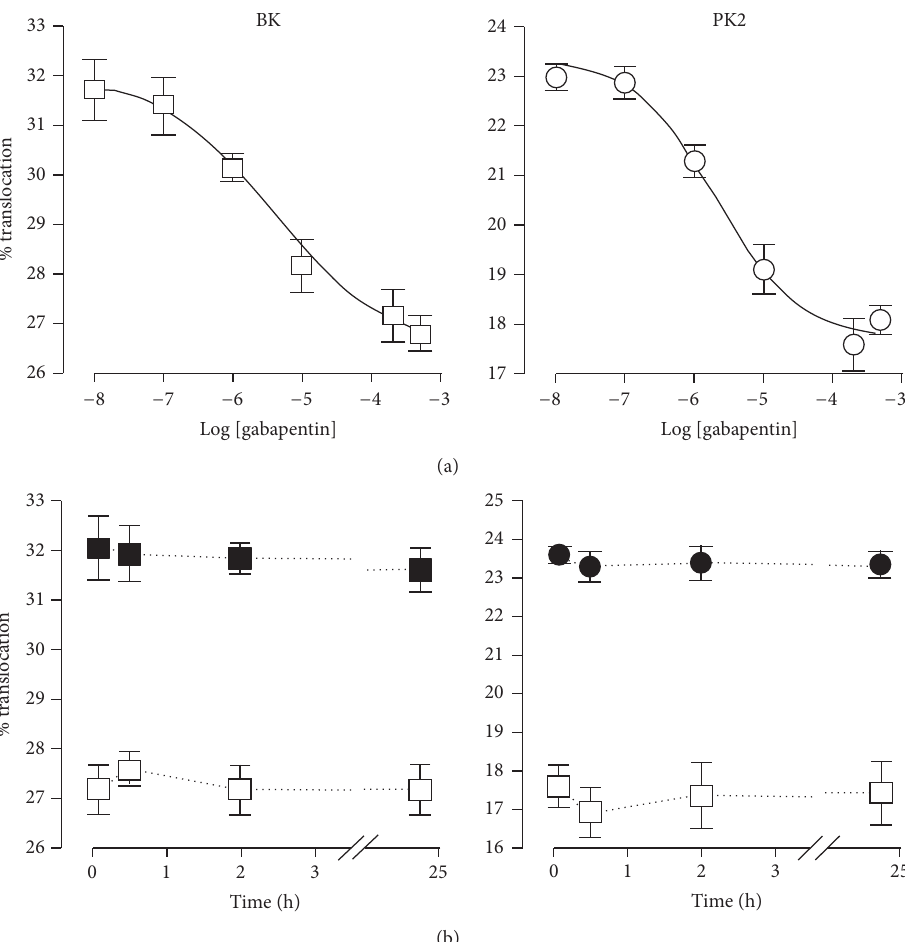
Figure 2: PKC translocation induced by bradykinin and PK2 is dose-dependently inhibited by gabapentin. (a) Gabapentin dose-response data on bradykinin-induced (white square symbols) and PK2-induced translocation (white circles). Gabapentin was preapplied for 5 minutes, and then neurons were treated with 1 𝜇 M bradykinin or 100 nM PK2 for 30s in the presence of the same preapplied concentration. (b) Time course of translocation at different times in control culture medium (black symbols) and in the same medium with 200 𝜇 M gabapentin added (white symbols). Both bradykinin- and PK2-induced translocation and gabapentin effect are not time-dependent in these conditions. See Results for further details. Notes: values are means ± SEM of data from 4–7 separate